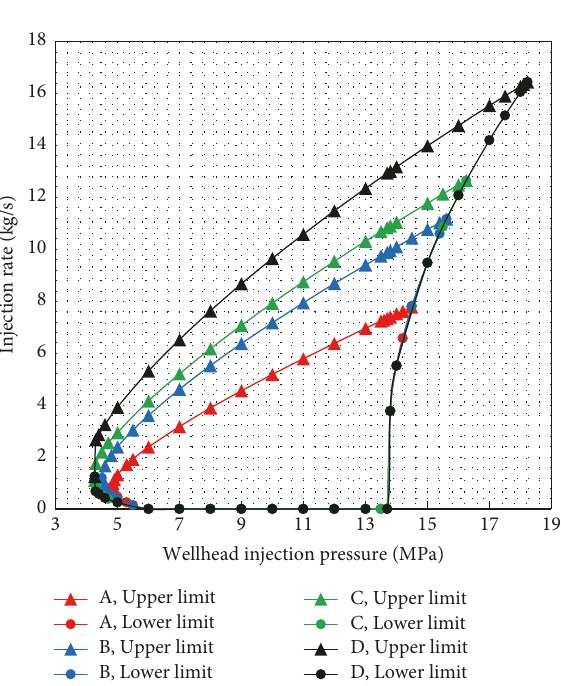
Figure 9: Relationship diagram between wellhead injection pres- sure and injection rate at different reservoir